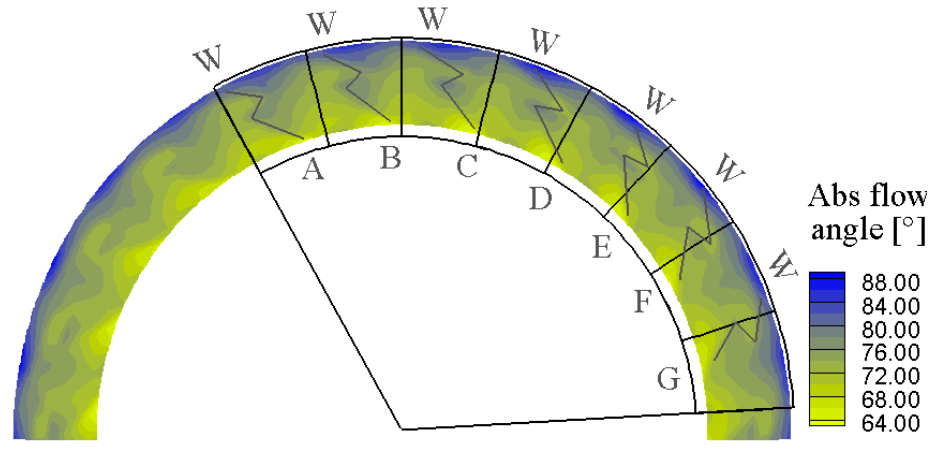
Figure 10. Snapshot of absolute flow angle distribution over multiple channels in different stator– rotor positions.